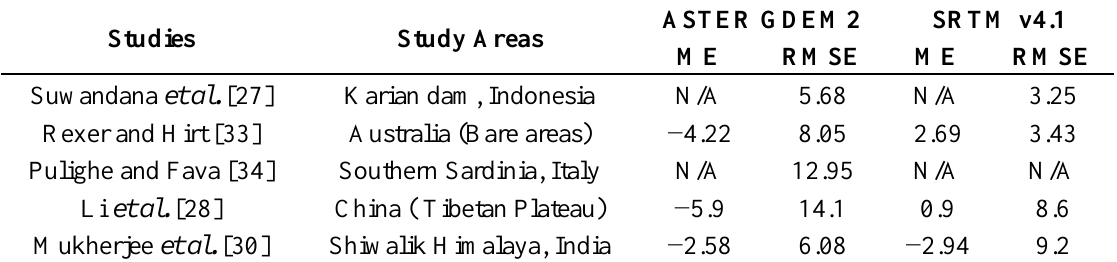
Table 3. Varying reported height accuracies for the ASTER GDEM2 and SRTM v4.1 DEMs (unit in